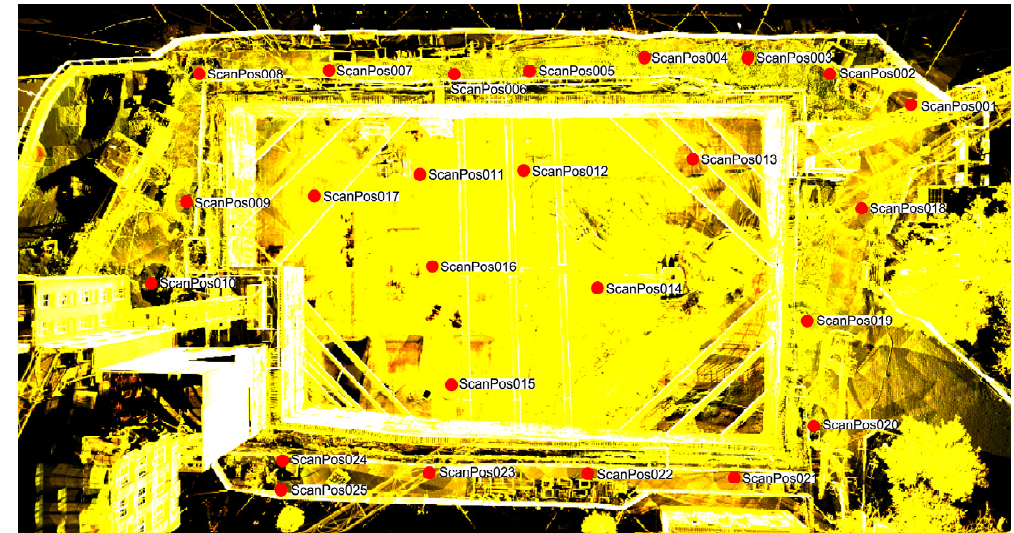
Figure A2. Distribution of scanner stations on the construction site.